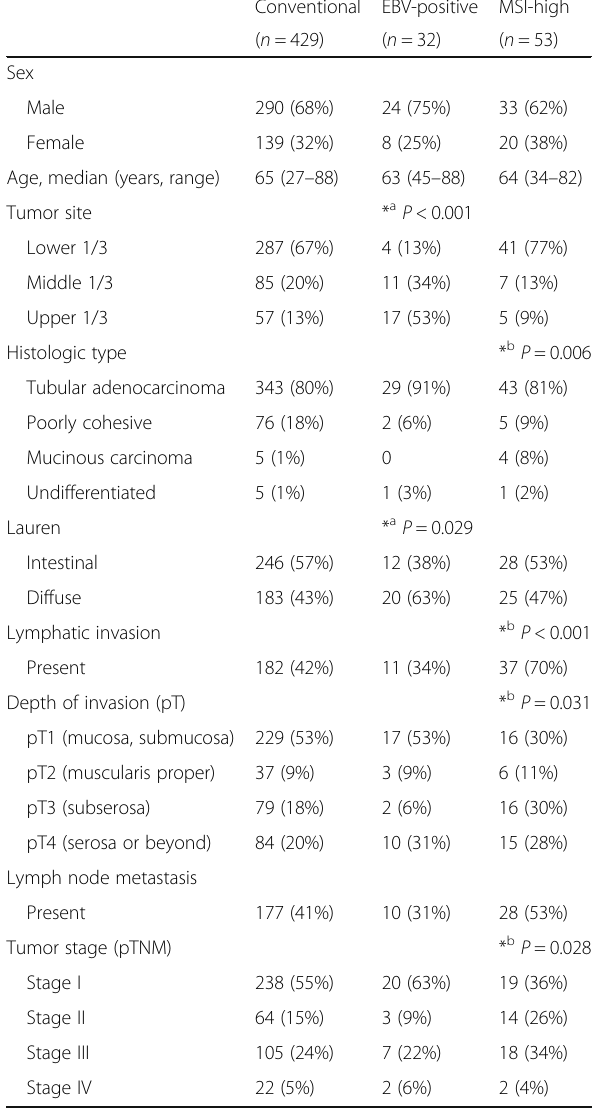
Table 2 Clinicopathological Features in Each Molecular Group Conventional EBV-positive